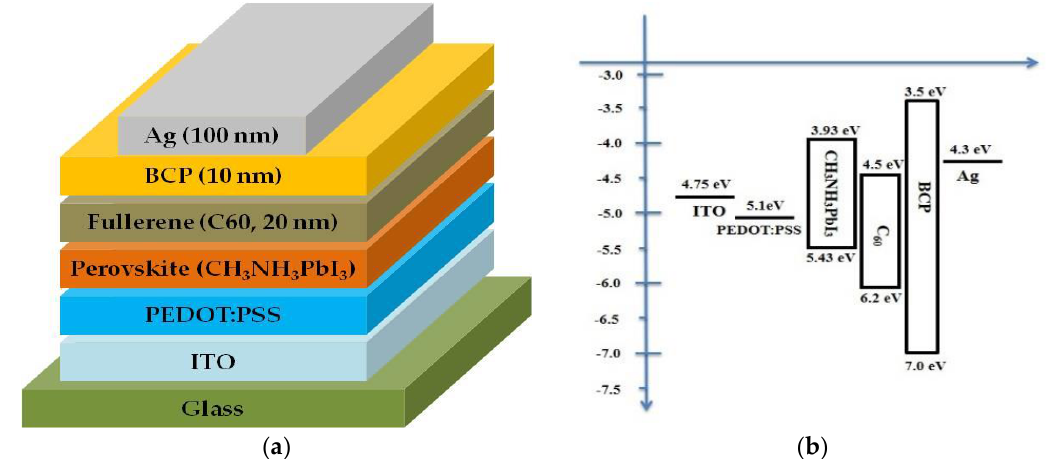
Figure 1. The ( a ) structure and ( b ) energy level of each material used for perovskite solar cells (PSCs) in this study.